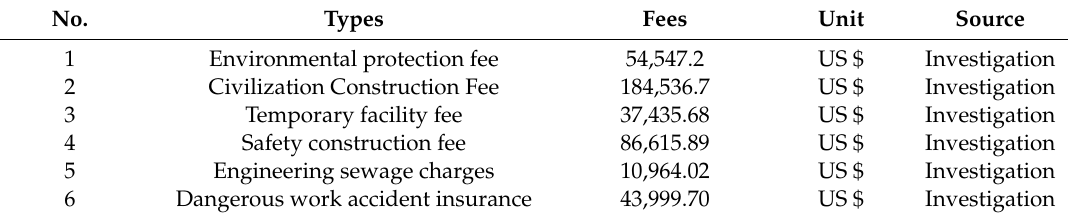
Table 5. Service and management fees for the government.